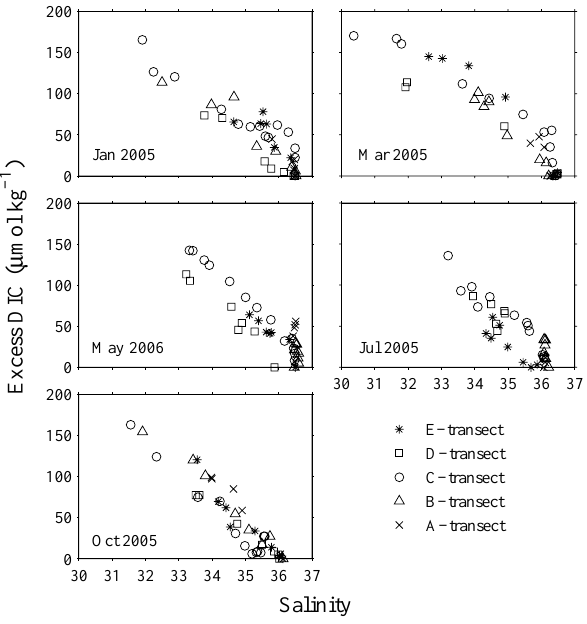
Fig. 11. Surface water total excess DIC (in excess of DIC from oceanic sources) plotted against salinity in January, March, July, October 2005 and May 2006 in the South Atlantic Bight. Due to lack of data, total excess DIC in December 2005 was not calculated.